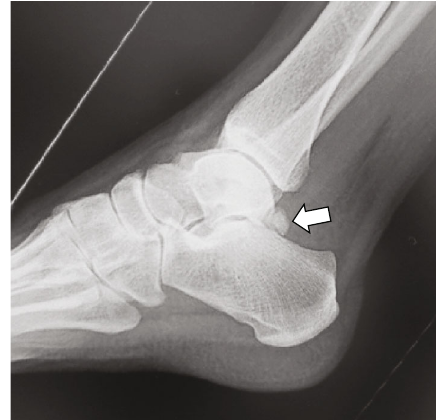
Figure 2: Lateral radiograph showing the os trigonum